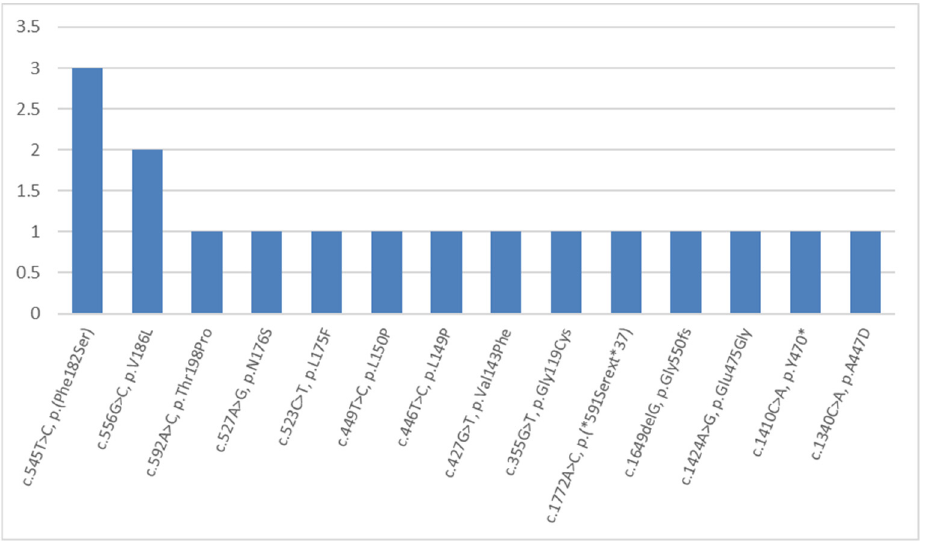
Figure 5. The frequencies and spectrum of detected mutations in the KRT5 gene in Russian children with EB simplex.